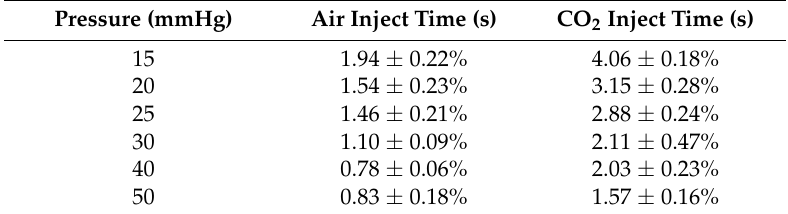
Table 1. Average injection times at different hydrostatic pressures, when the SUITE control algorithm reaches the steady ‐ state.